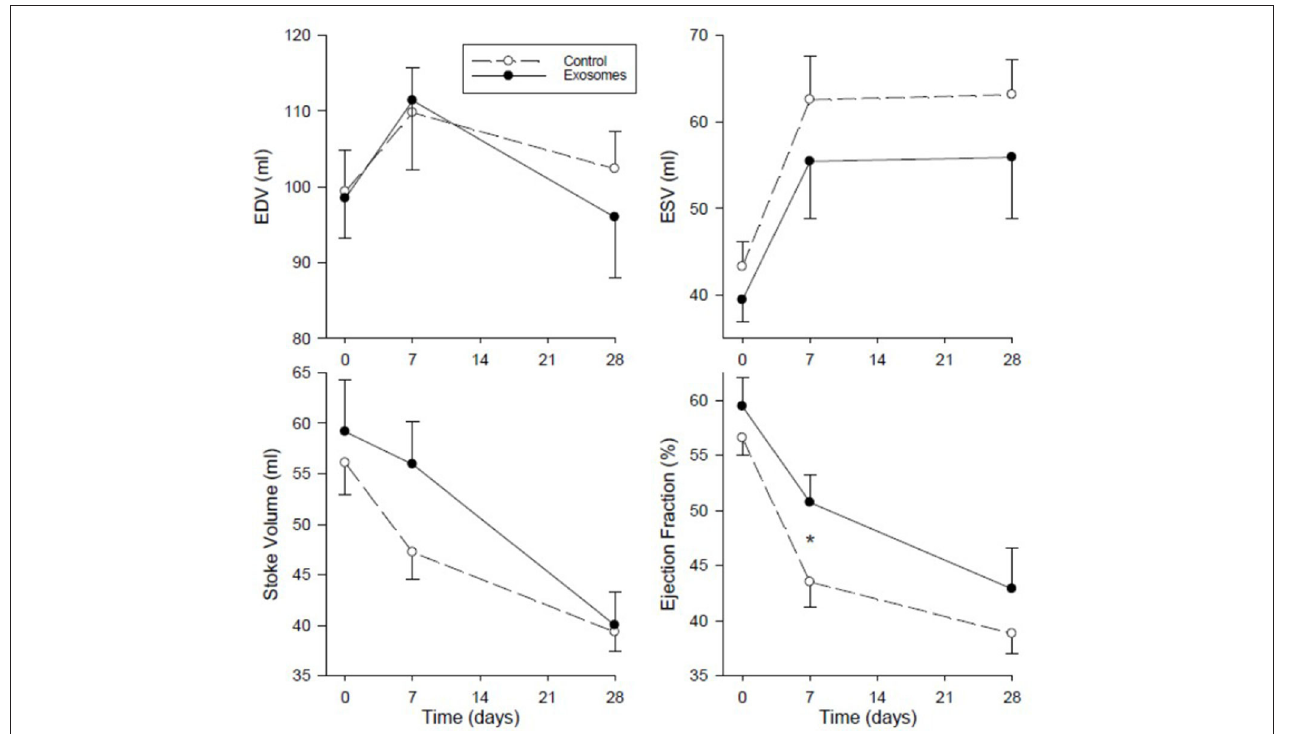
FIGURE 6 | Serial left ventricular end diastolic volume (EDV), end systolic volume (ESV), stoke volume, and ejection fraction measured by MRI in ten pigs receiving 7 days intravenous administration of exosomes (•) following MI and ten pigs vehicle control ( ◦ ) treated pigs. Values shown are mean ± SEM. Significant differences at time-matched points between the exosomes and control pigs are indicated as follows: * p <